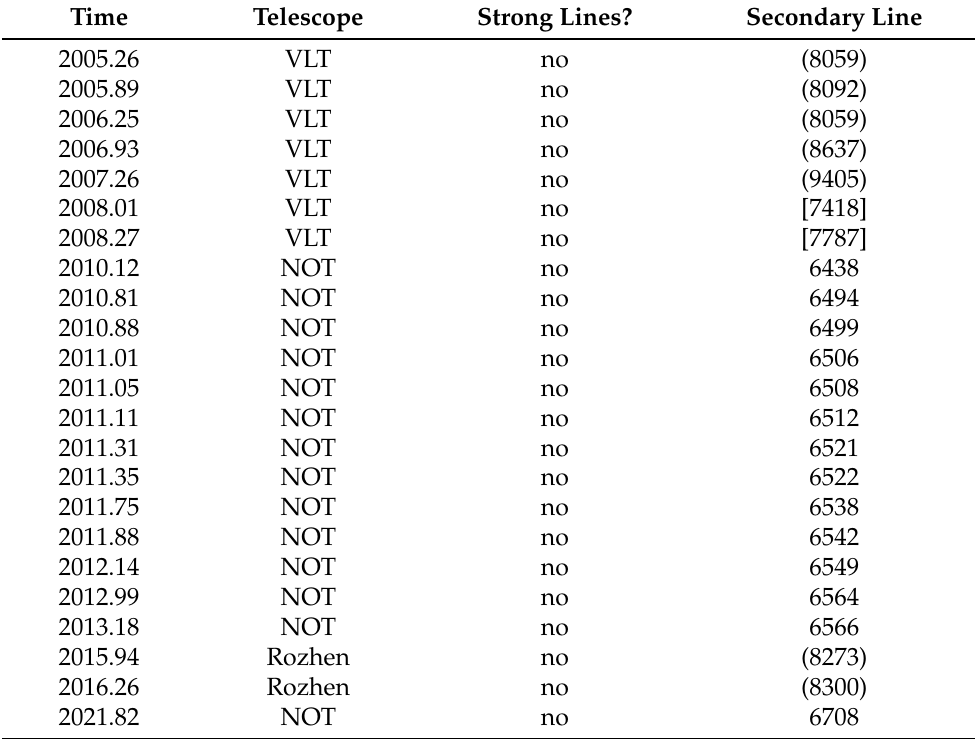
Table 2. The epochs of the line monitoring